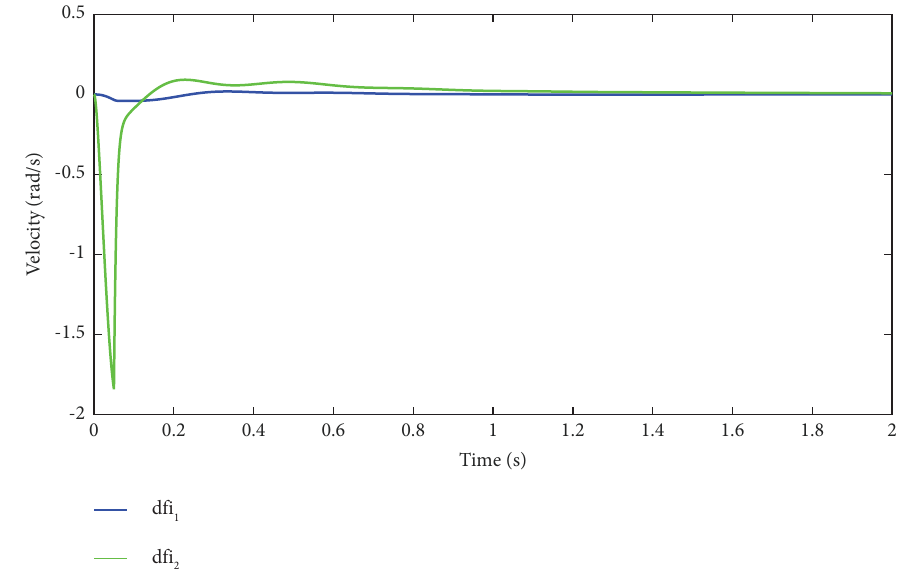
Figure 7: Angular velocities of parts of the mobile antiaircraft weapon system after the launch: dφ dφ 2 -angular velocity of the